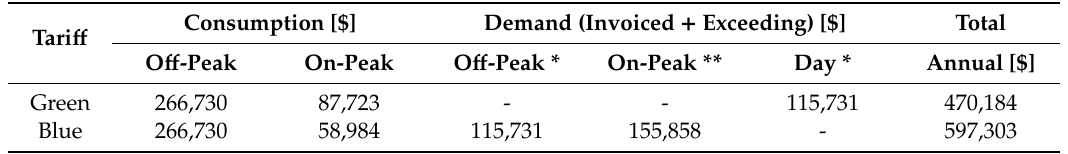
Table 13. Main results for Scenario